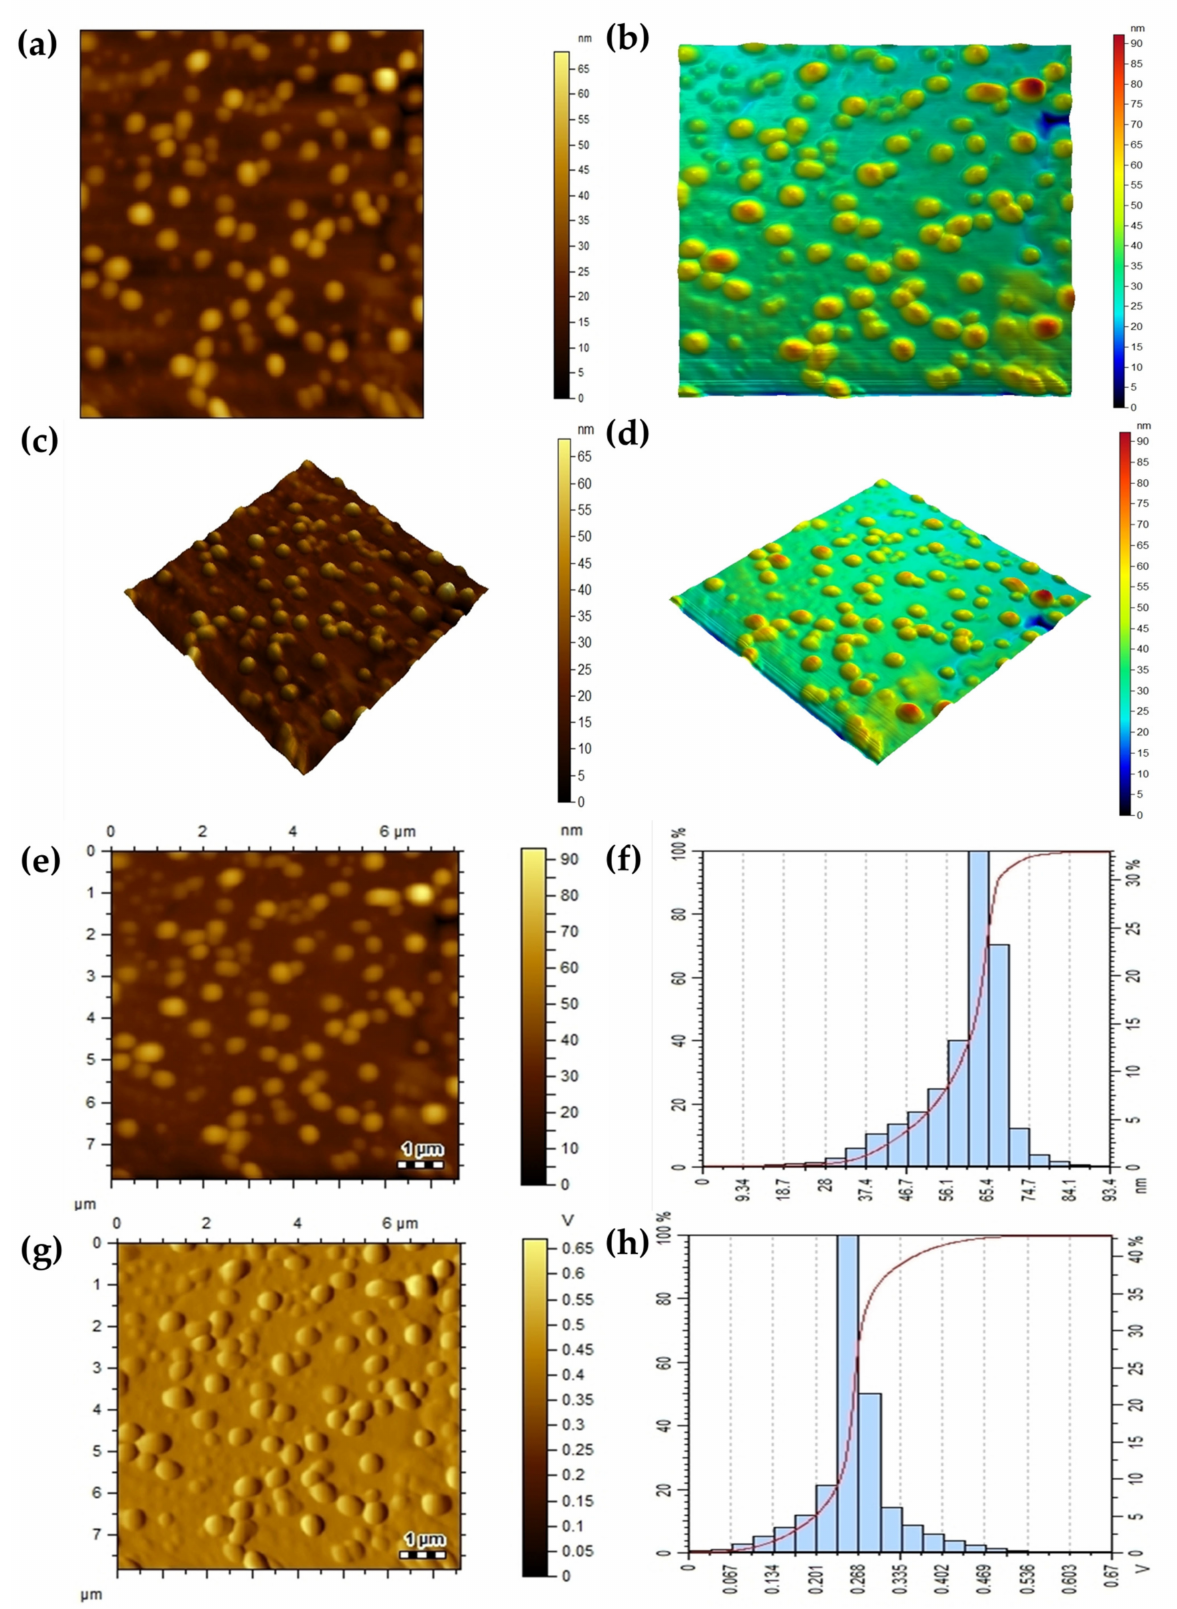
Figure 6. ( a , b ) Topographical 2D AFM images; ( c , d ) identical 3D AFM images; ( e , f ) typical histogram of particle size distribution; ( g , h ) typical histogram of particles volume distribution of the synthesized Carbopol/ZnO hybrid nanoparticles